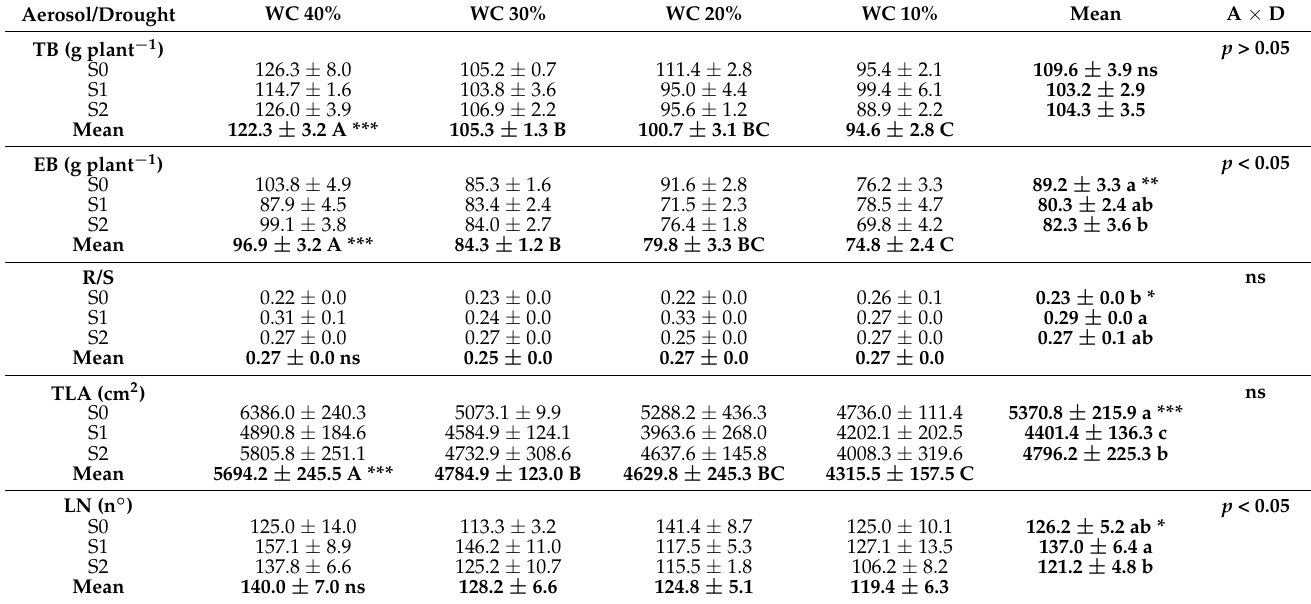
Table 3. Effects of drought and saline aerosol treatments on total (TB) and epigeous (EB) dry biomass, root/shoot ratio (R/S), total leaf area (TLA), and leaf number (LN) of potted Viburnum plants.